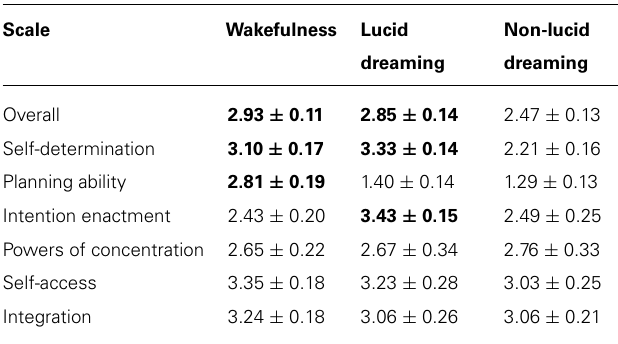
Table 1 | Experienced volition during wakefulness, lucid dreaming and non-lucid dreaming according to theVolitional Components Questionnaire (VCQ) overall and subscale